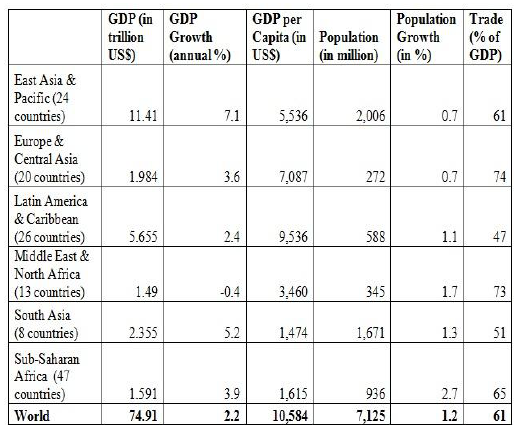
Table 1: Descriptive Statistics of Emerging Markets: 2013 (Using data from the World